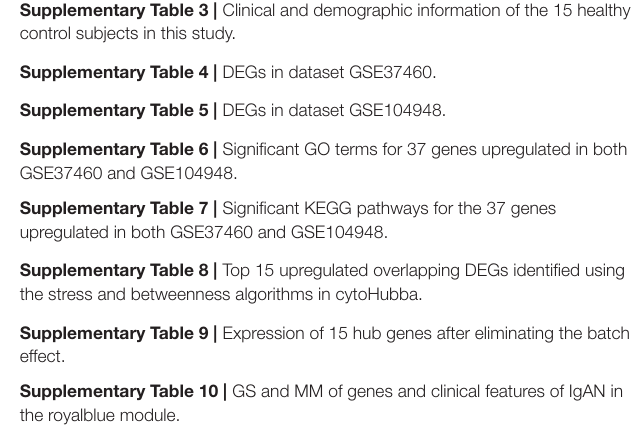
Supplementary Figure 1 | Boxplot of original and normalized gene expression in GEO datasets. (A,B) Boxplot of original gene expression in GSE37460 (A) and GSE104948 (B) . (C,D) Boxplot of normalized gene expression in GSE37460 (C) and GSE104948 (D) . Supplementary Figure 2 | GO and KEGG pathway analyses of 37 upregulated genes overlapping between GSE37460 and GSE104948. (A–C) GO analysis of 37 genes showing Biological process (A) , Cellular component (B) , and Molecular function (C) categories with threshold count ≥ 2 and P < 0.05. (D) KEGG pathway analysis showing pathways associated with the 37 upregulated genes according to a threshold count ≥ 2 and P < 0.05. Supplementary Figure 3 | Relationship between key modules and clinical features of IgAN in the royalblue module. (A,B) Scatterplots of GS vs. MM in the royalblue module with albumin:creatinine ratio (ACR) and CKD stage in IgAN patients. Correlations between GS and creatinine and eGFR were – 0.34 ( P = 5e − 04) and 0.11 ( P = 0.27), respectively. Supplementary Figure 4 | Cluster trees and heatmaps for creatinine and eGFR in different modules in the WGCNA. (A) Creatinine. (B) eGFR. Supplementary Table 1 | Clinical and demographic information of patients with IgAN in the GSE93798 dataset. Supplementary Table 2 | Clinical and demographic information of the 35 IgAN patients in this study. Supplementary Table 3 | Clinical and demographic information of the 15 healthy control subjects in this study. Supplementary Table 4 | DEGs in dataset GSE37460. Supplementary Table 5 | DEGs in dataset GSE104948.